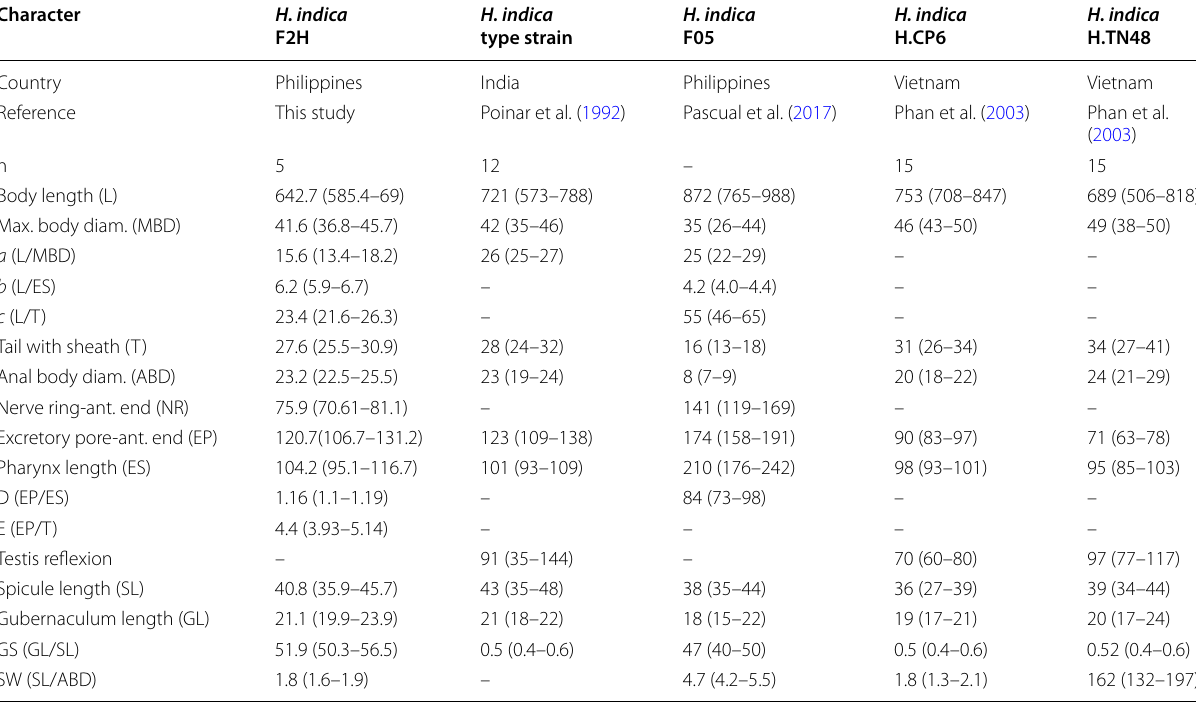
All morphometric measurements are in µm (except n, ratio and percentage) and expressed as means